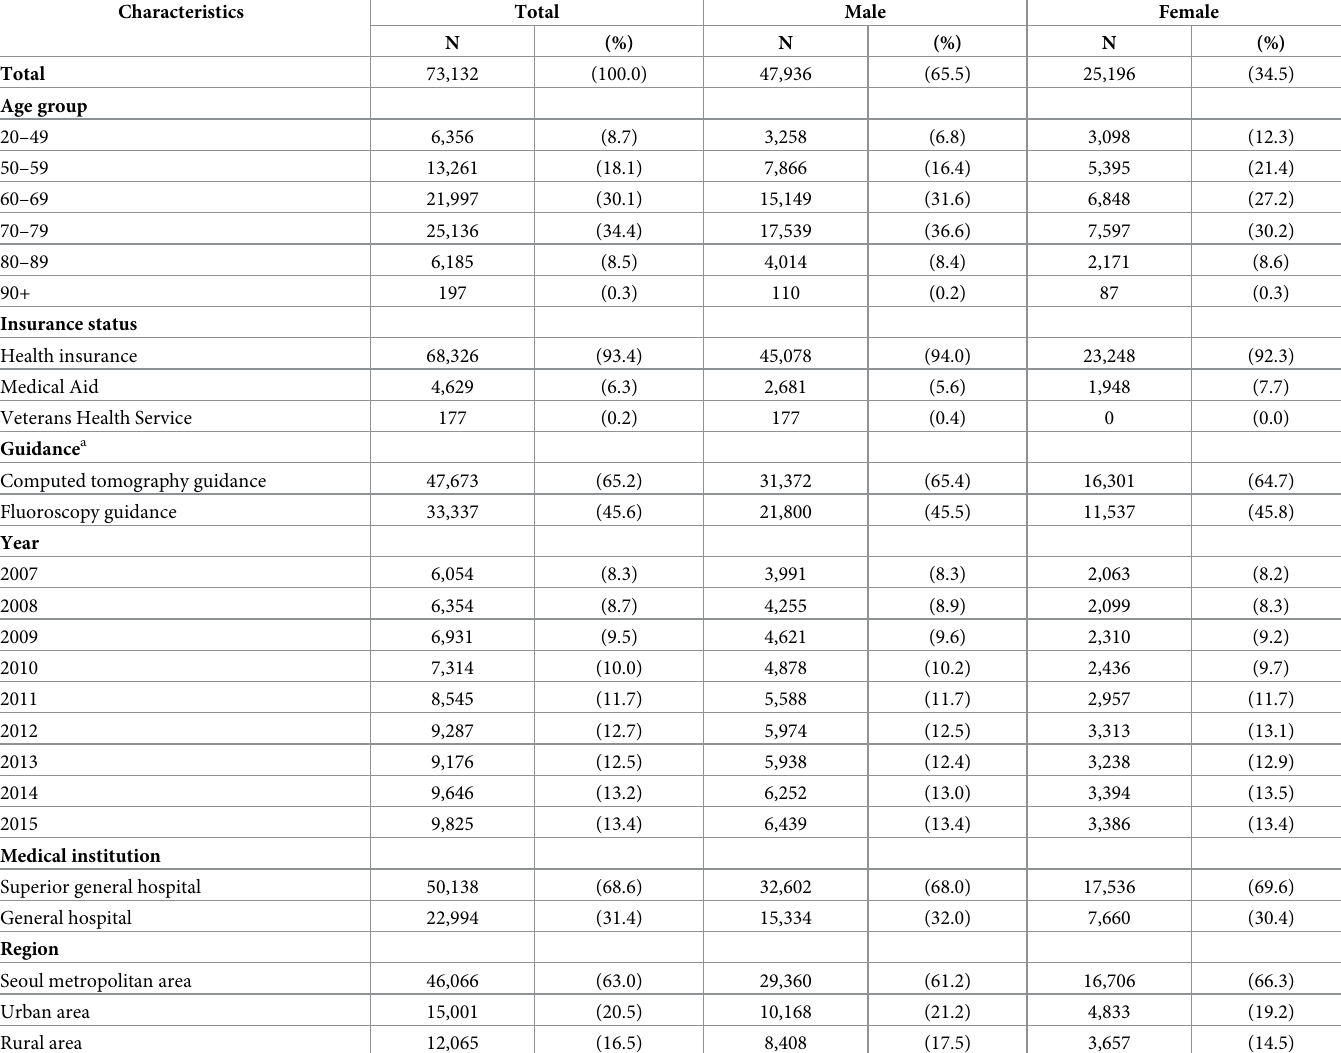
Table 1. Baseline characteristics of percutaneous transthoracic needle biopsies of the lung from 2007 to